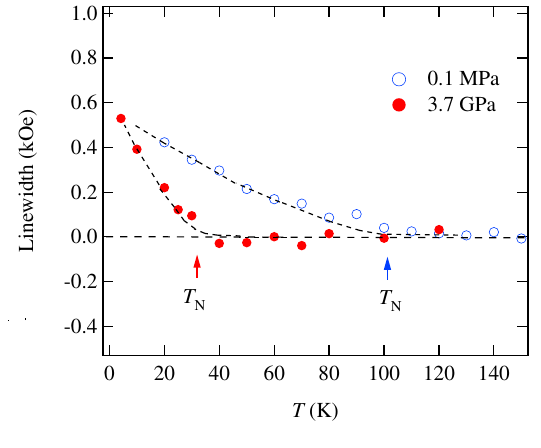
Figure 4: The increase in 1 H linewidth due to the or- dered spin moments. T N represents the antiferromag- netic (AF) transition temperature.